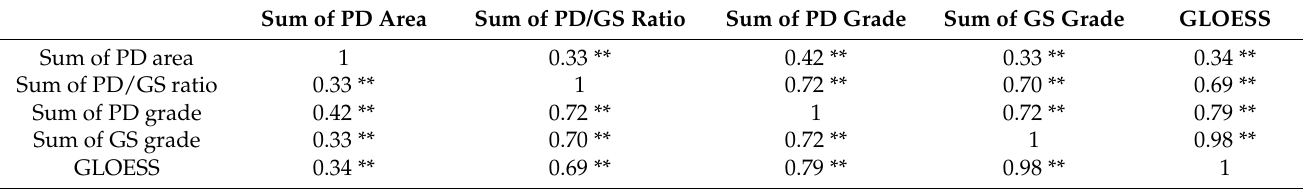
Table 3. Correlations between musculoskeletal ultrasonography